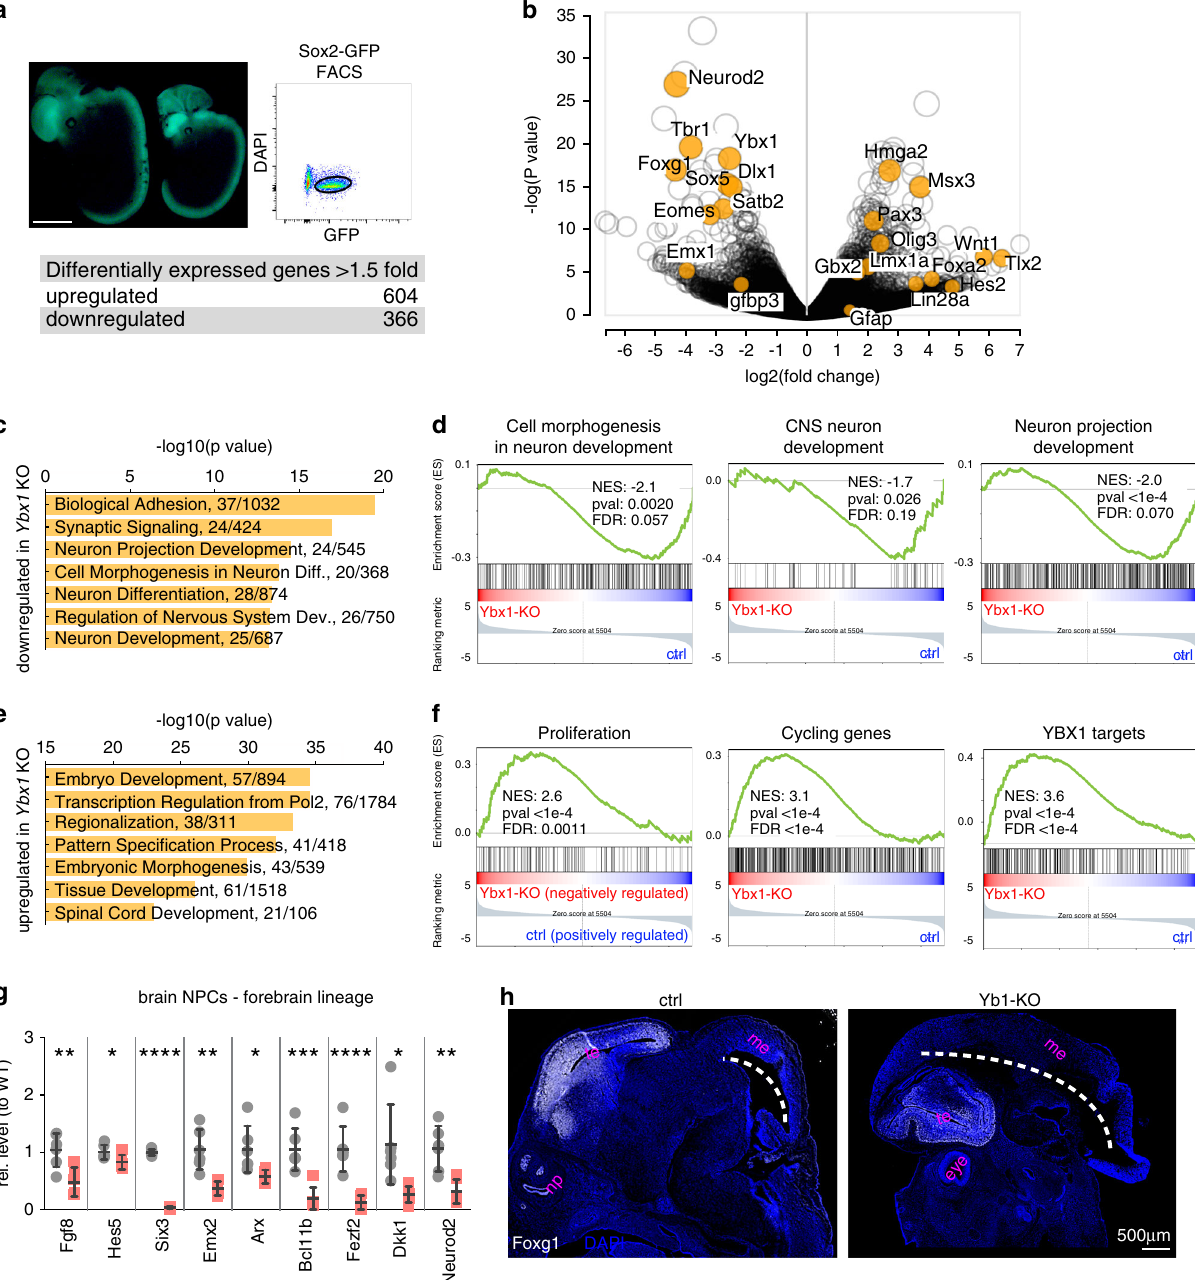
Fig. 2 Differential gene expression in control and Ybx1 -KO NPCs puri fi ed from embryos. a Image of Ybx1 -KO and sibling control embryos expressing Sox2-GFP. Bar, 2 mm. Representative plot of Sox2-GFP FACS. Summary of differentially expressed genes in Sox2-GFP – positive NPCs from Ybx1-KO. b Volcano plot comparing transcript pro fi les of four samples of control NPCs and three samples of Ybx1 -KO NPCs. p- values by two-tailed unpaired t test in limma package. Gene ontology analysis identi fi ed ontology terms of c downregulated or e upregulated genes in Ybx1 -KO vs. control NPCs. Terms were ranked by P value, calculated by two-tailed Fisher ’ s exact test, with the number of enriched genes indicated. GSEA identi fi ed enrichment gene sets in d downregulated or f upregulated genes in Ybx1 -KO NPCs. P values were calculated by one-tailed Kolmogorov – Smirnov statistic test. g RT-qPCR with TaqMan assays of forebrain lineage markers in NPCs puri fi ed from brains of Ybx1 -KO or sibling control embryos at E13.5. n = 6. Data are presented as mean ± SEM for g . P values by two-tailed unpaired t test are indicated. n.s., not signi fi cant. *, **, ***, and **** indicate P < 0.05, 0.01, 0.001, and 0.0001, respectively, by one-sided Student ’ s t test. h Foxg1 IF in cryosection from Ybx1 -KO or sibling control embryos at E13.5. Bar, 500 μ m. Te telencephalon, me mesencephalon, np nasal plate. Source data are provided in Source Data fi le. P values: 2 g (Fgf8)-0.005, (Hes5)-0.03, (Six3)-<0.0001, (Emx2)-0.001, (Arx)-0.03, (Bcl11b)-0.0005, (Fezf2)-0.0003, (Dkk1)-0.01